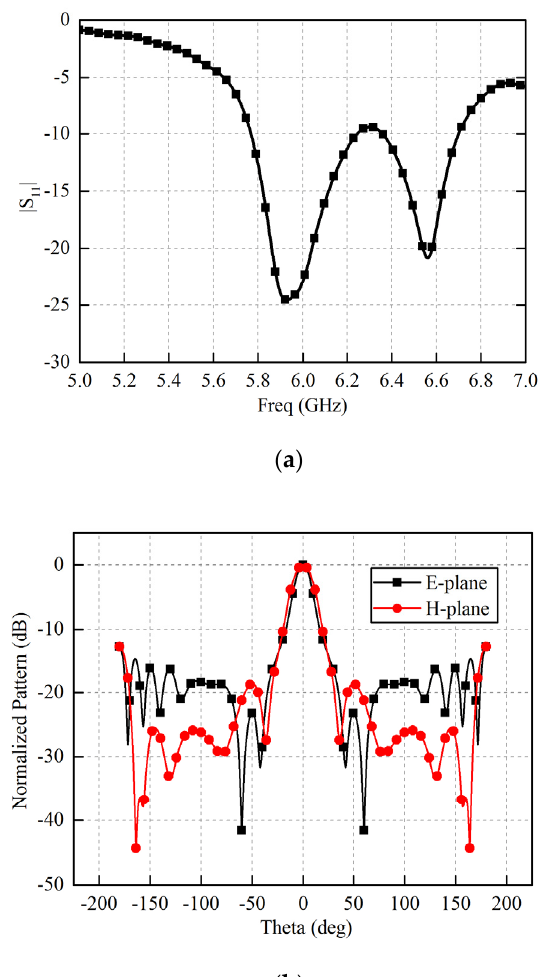
Figure 6. Simulated performances of the FPRA with a traditional planar superstrate. ( a ) |S 11 |; ( b ) radiation pattern at 6 GHz.